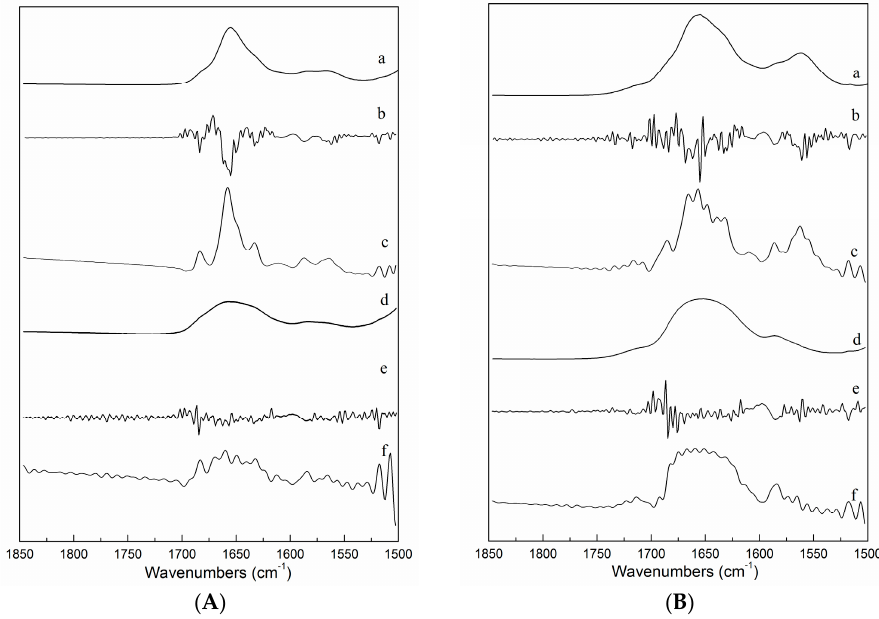
Figure 2. IR spectra of ICFs ( A - a : original spectra at 5 °C; A - b : second derivative spectra at 5 °C; A - c : FSD spectra at 5 °C; A - d : original spectra at 50 °C; A - e : second derivative spectra at 50 °C; A - f : Fourier self-deconvolved spectra at 50 °C) and PSCs ( B - a : original spectra at 5 °C; B - b : second derivative spectra at 5 °C; B - c : FSD spectra at 5 °C; B – d : original spectra at 50 °C; B - e : second derivative spectra at 50 °C; B - f : Fourier self-deconvolved spectra at 50 °C).